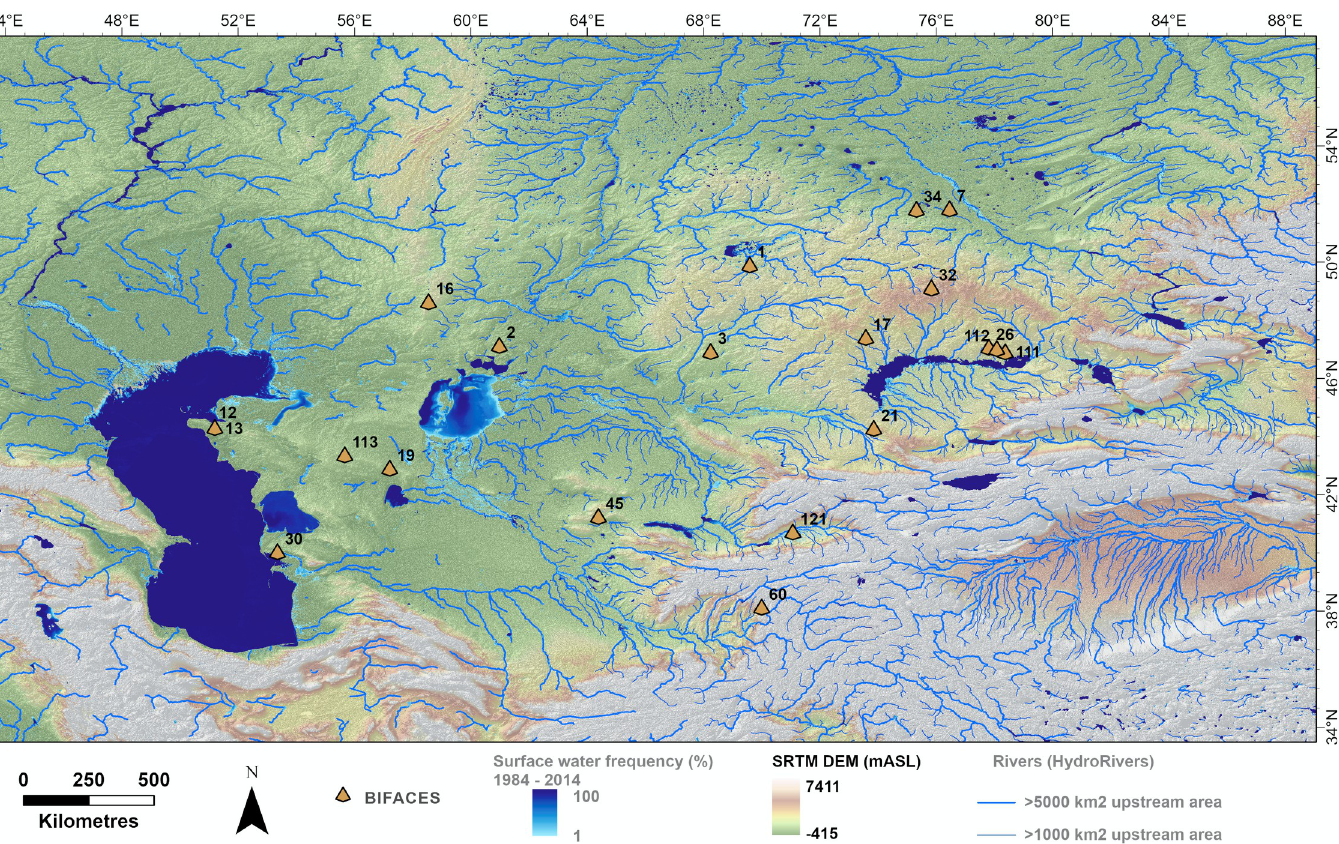
Fig 4. Distribution of acheulean-like bifaces. Elevation data for Central Asia (SRTMV4 [114]) with bodies of water [15], rivers (Hydrosheds [16]) and the boundaries of Central Asia outlined. Areas where bifaces have been recovered are marked (orange triangle). Numbers correspond to the sites listed in S1 Table.